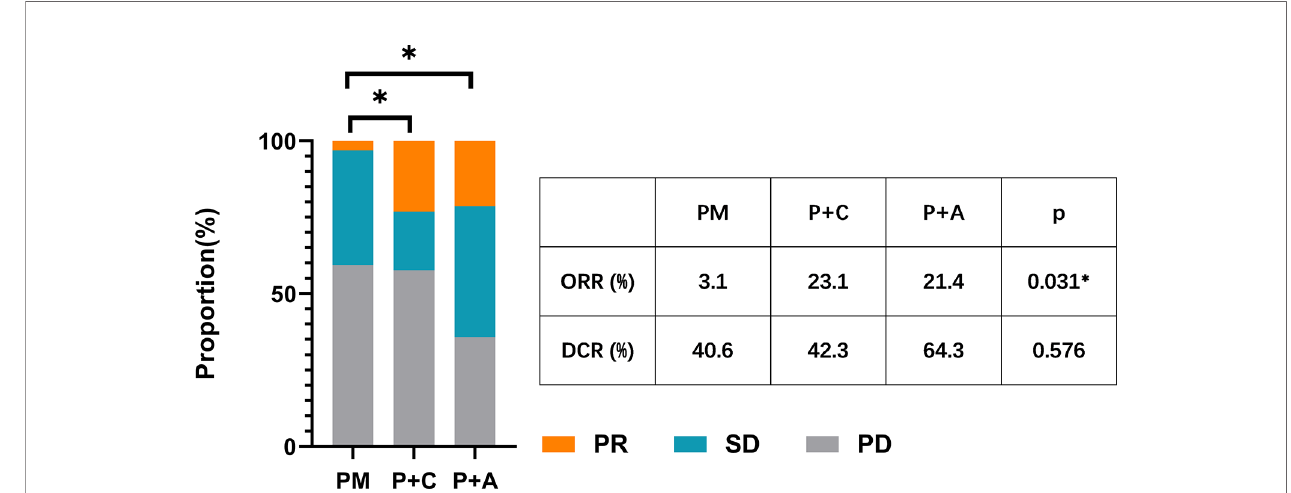
FIGURE 3 | The ORR and DCR of patients in PM, P+C and P+A groups. * represents a statistically signi fi cant difference.